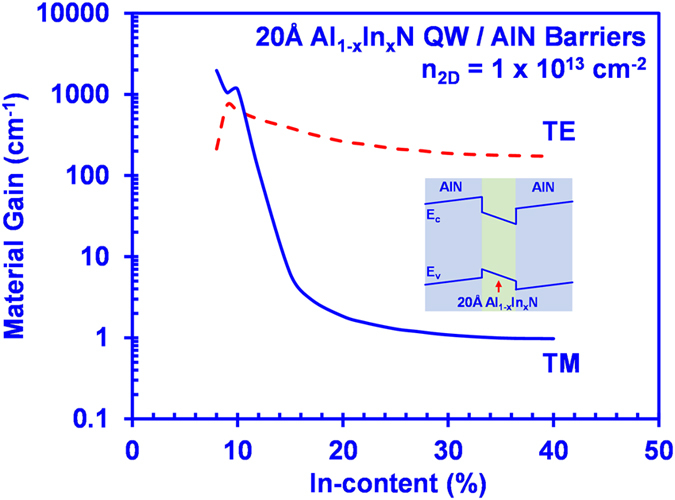
TM peak material gains (gTMpeak) and TE peak material gains (gTEpeak) as a function of In-content (x) for 20 Å AlInN conventional QW with AlN barriers for n2D = 1 × 1013 cm−2.